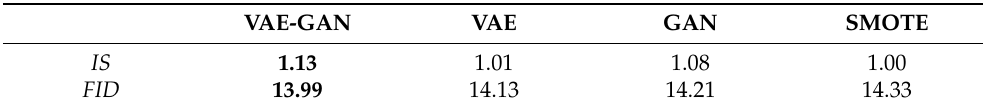
Table 4. IS and FID of proposed and conventional